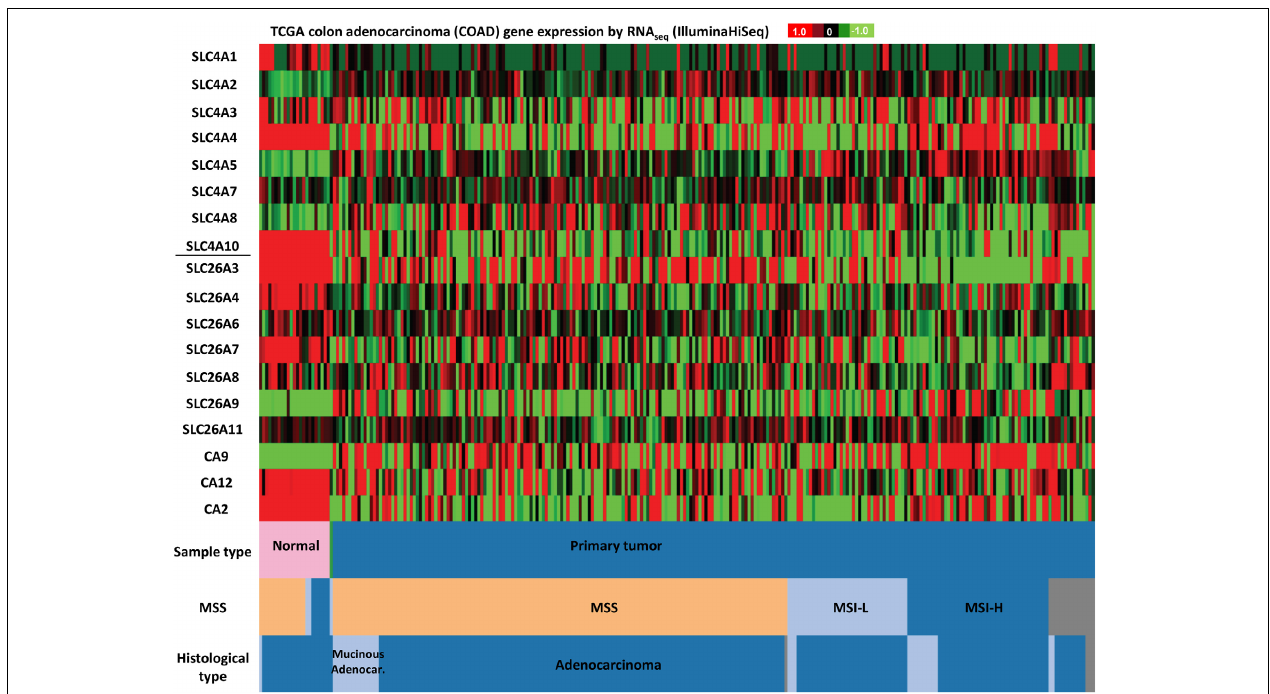
FIGURE 5 | SLC4 and SLC26 family mRNA expression levels in colorectal cancer. RNA sequencing data (ID: TCGA_COAD_exp_HiSeqV2, N = 272) from The Genome Cancer Atlas database was processed and visualized with UCSC Cancer Genomics Browser (https://genome-cancer.ucsc.edu). The